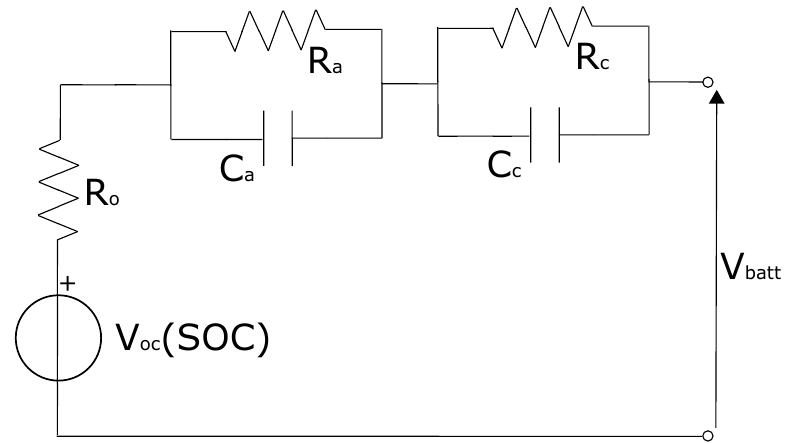
Figure 10. Equivalent dynamic circuit model of the battery pack.